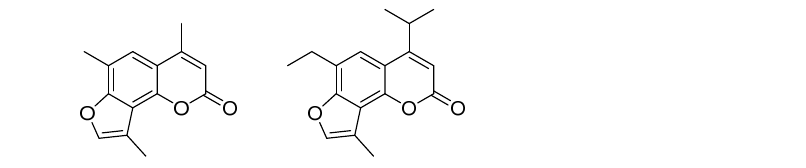
Figure 1. Structure of 4,6,4 ′ -trimethylangelicin (TMA) and 4-isopropyl-6-ethyl-4 ′ -methylangelicin (IPEMA).